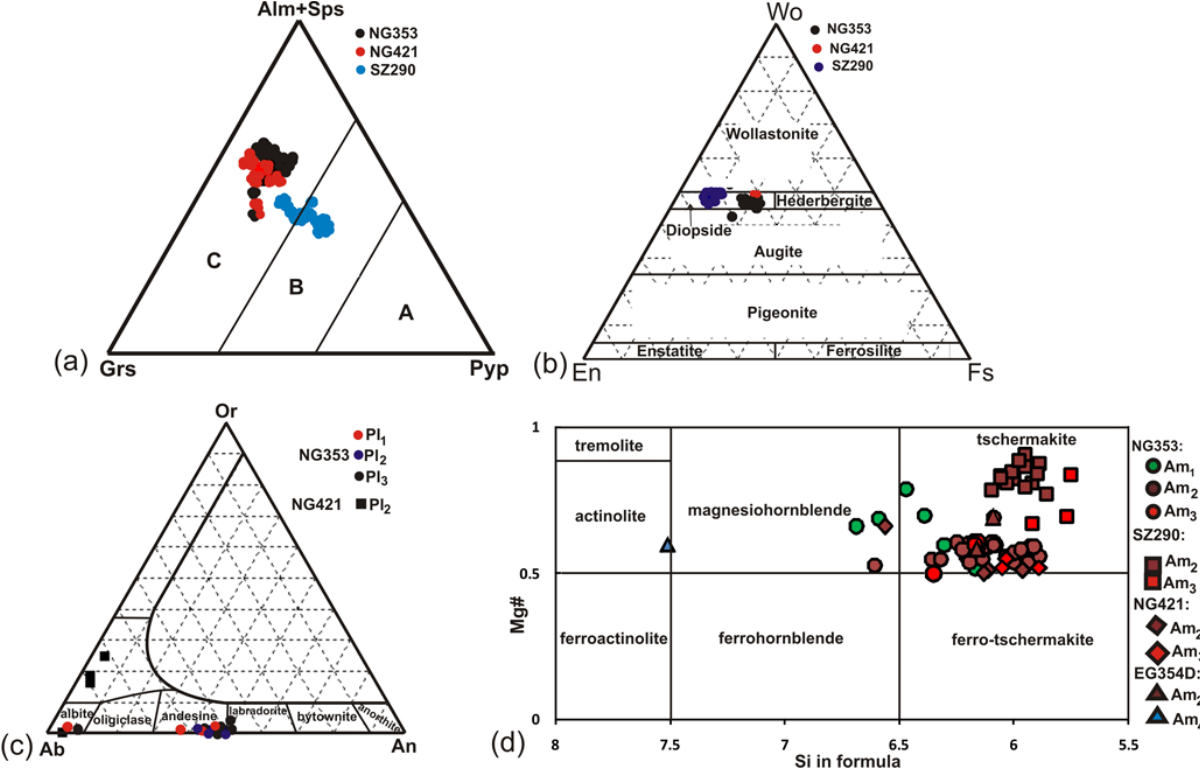
Fig. 8. Mineral classification diagrams. (a) Garnet, after Coleman et al. (1965); (b) pyroxene and (c) feldspar, after Deer et al. (1991); (d) amphibole, after Leake et al.